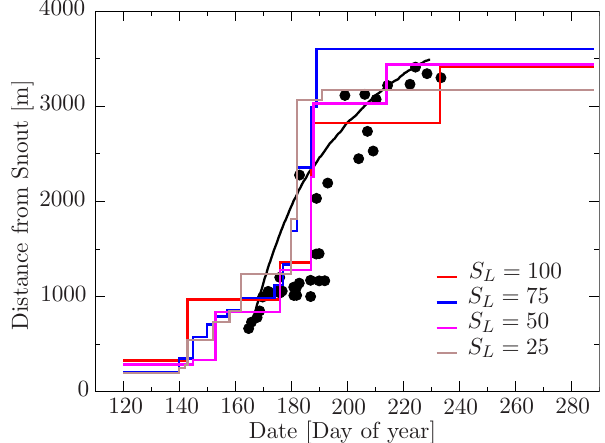
Fig. 11. Comparison of the evolution of the maximum length of the modelled EPL for different grid specific length (coloured lines). The position of the head of the channelized drainage system de- rived from observations (black dots) and the interpretation of the channel spreading by Nienow et al. (1998) (black line) are shown for comparison. The modelling is performed using the modelled water input of the 1993 melt season (Arnold et al., 1998) with position of the head of the channelized system is computed follow- ing Nienow et al. (1998) using dye-tracing data from the 1990 melt season; the specific length ( S L ) for each simulation is given in me-